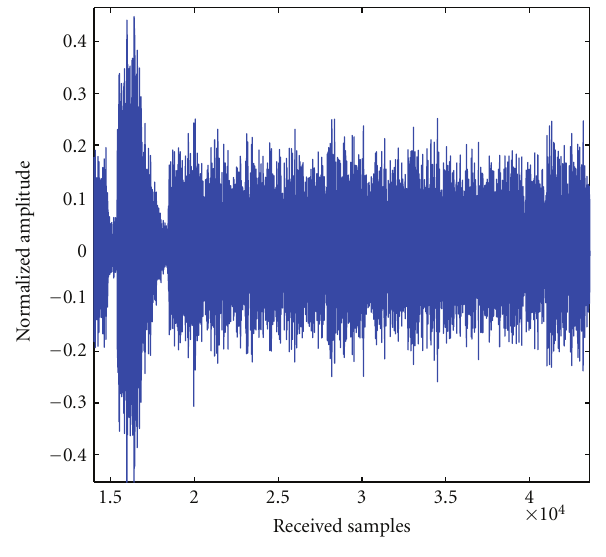
Figure 6: Received